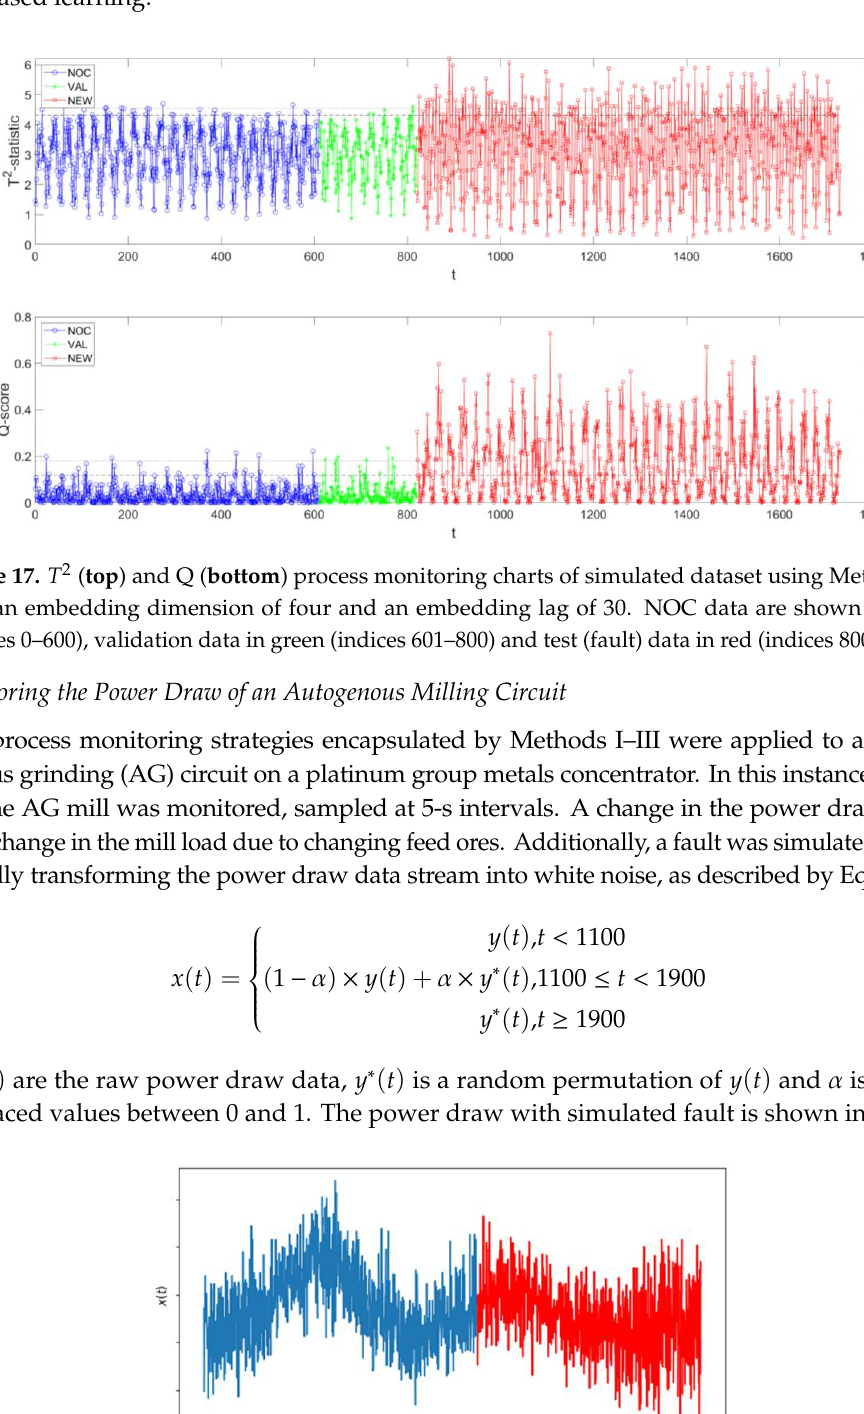
through the fault region (red).